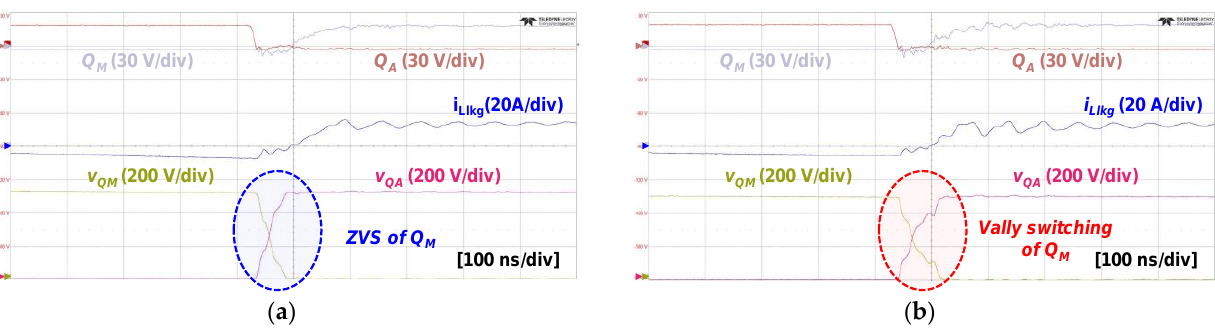
Figure 17. Soft-switching waveforms at full load conditions: ( a ) 200 V input. ( b ) 310 V input.